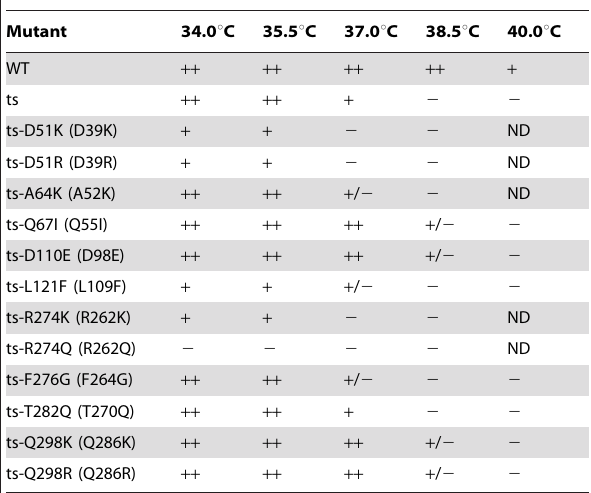
Results are for wildtype (WT), temperature-sensitive (ts), and ts virus with predicted stabilizing mutations. The plaques are scored as ++ for clear plaques, + for smaller or opaque plaques, + / 2 for barely distinguishable plaques, 2 for no plaques, and ND for not determined. The first mutation numbers are for sequential numbering of the A/WSN/33 hemagglutinin sequence beginning with zero at the N-terminal methionine, while the numbers in parentheses correspond to those used in the crystal structure with PDB code 1RVZ.